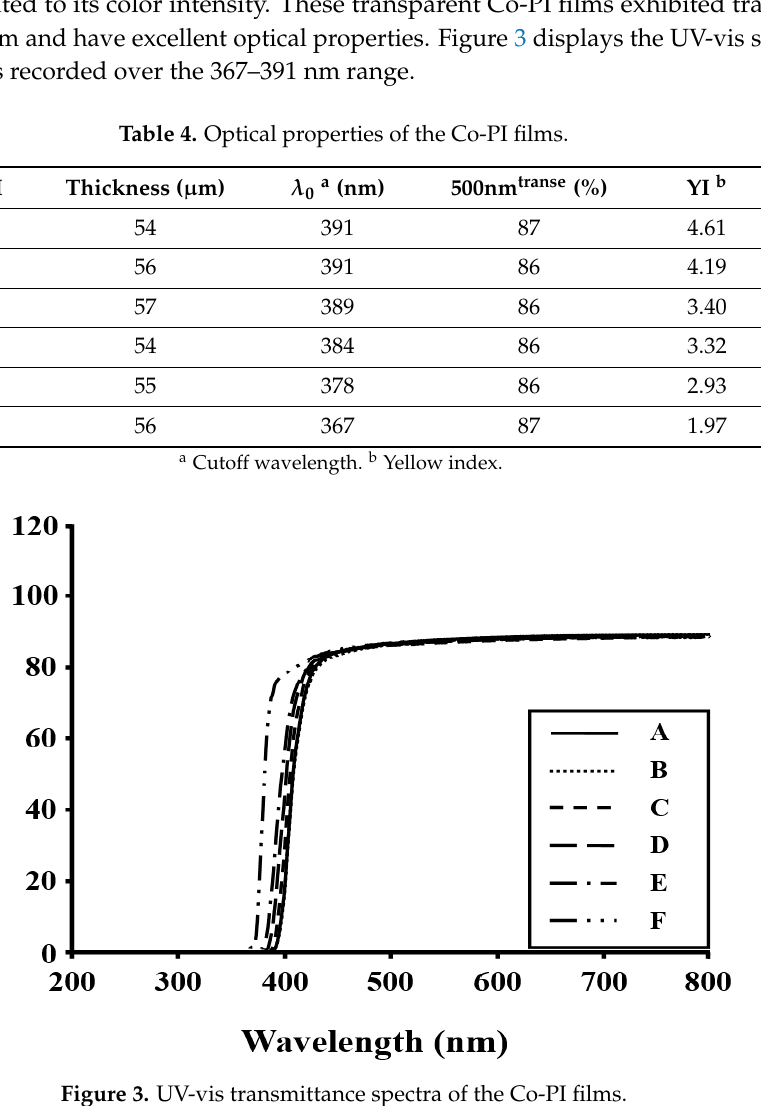
Table 4. Optical properties of the Co-PI films.